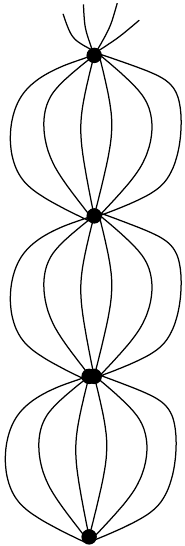
Figure 3.2. After shorting out the vertices on the same layer, the network reduces to a series of m vertices connected by E ∗ n unit resistors in